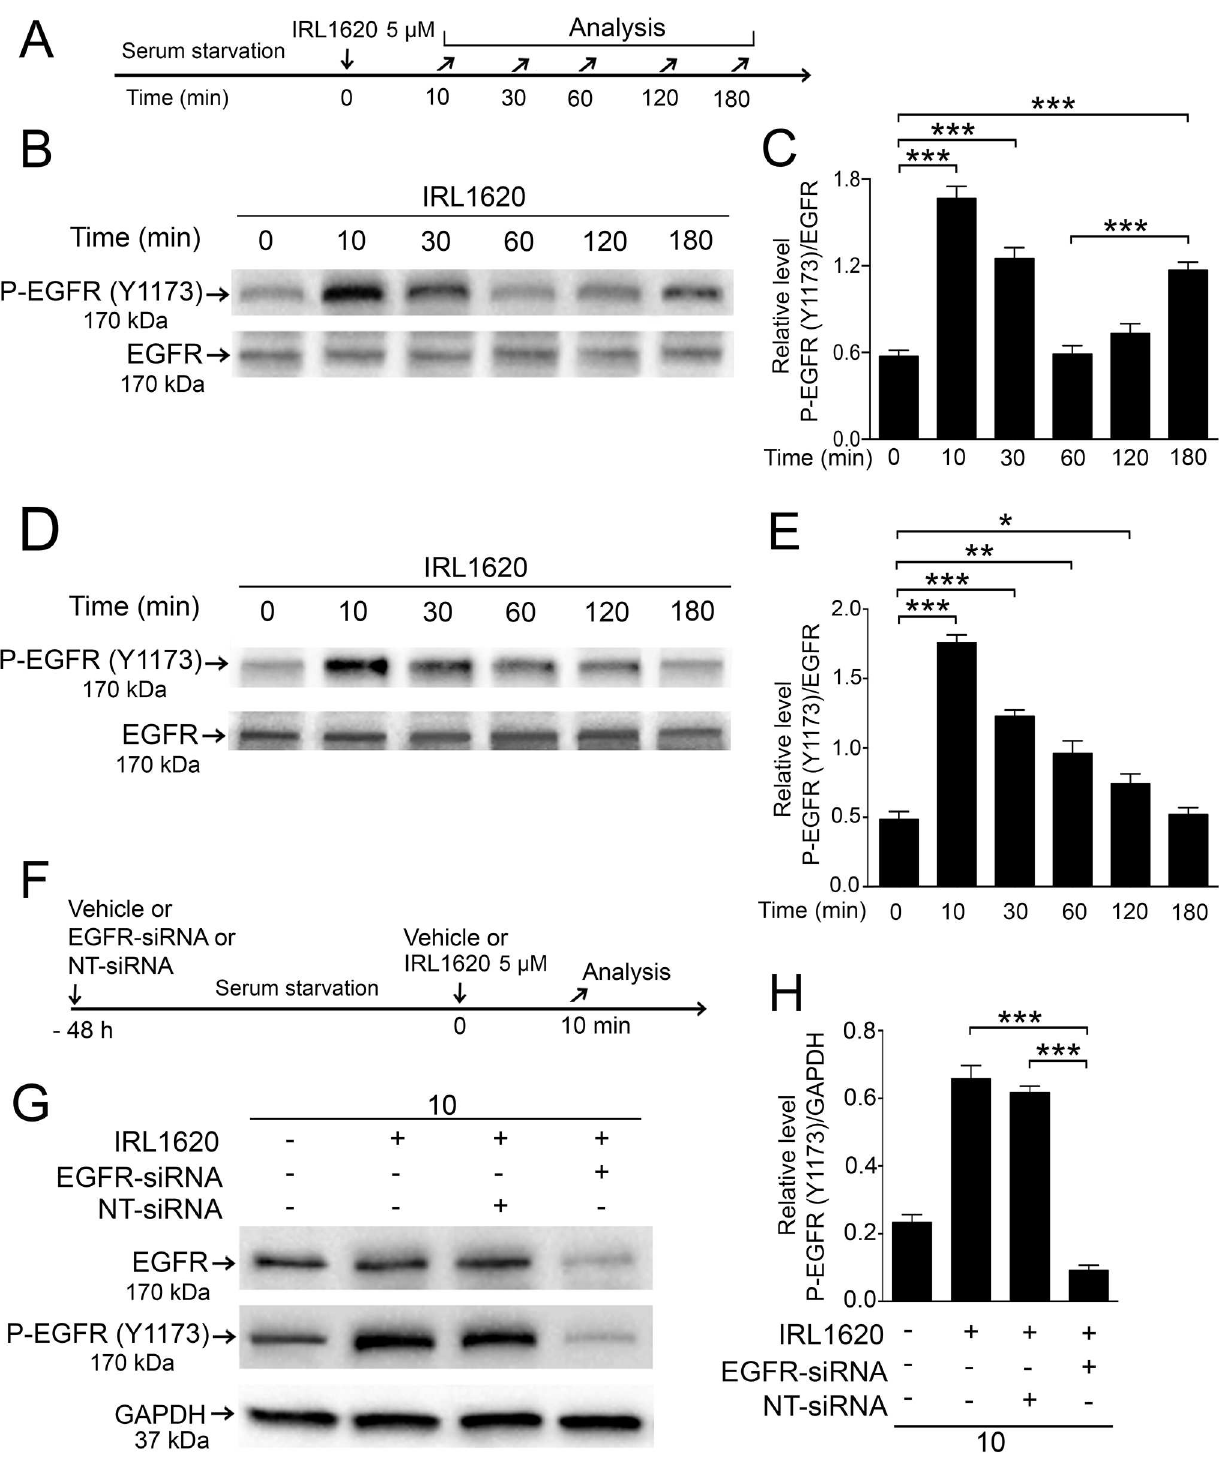
Fig 7. Effects of IRL1620 on Y1173-EGFR phosphorylation and EGFR-siRNA on IRL1620-induced Y1173-EGFR phosphorylation in Mu¨ller cells. Serum-starved cells treated with 5 μ M IRL1620and P-EGFR was analyzedat different time points from 10 min to 180 min. (A) Experimental outline. Western blot analysisof P-(Y1173)-EGFR in (B) primary chicken Mu¨ller cells and (D) the humanMIO-M1 cell line. Bar graphs with densitometry of P-EGFR levels normalized by total EGFR levels in (C) primary chicken Mu¨ller cells and (E) the humanMIO-M1 cell line. (F) MIO-M1 humanMu¨ller cells transfected with EGFR-siRNA or non-targeted siRNA (NT-siRNA) in absenceof serum for 48 h followed